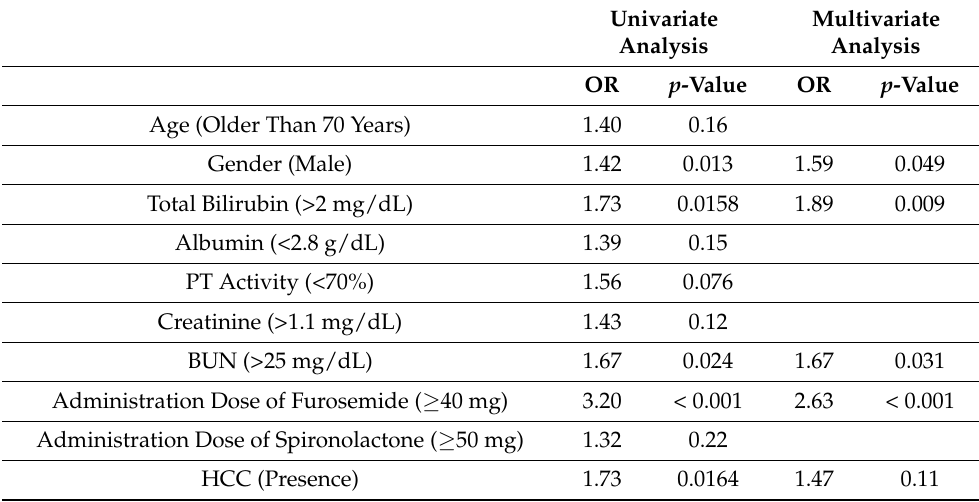
Table 3. The prognostic factors for survival in the tolvaptan